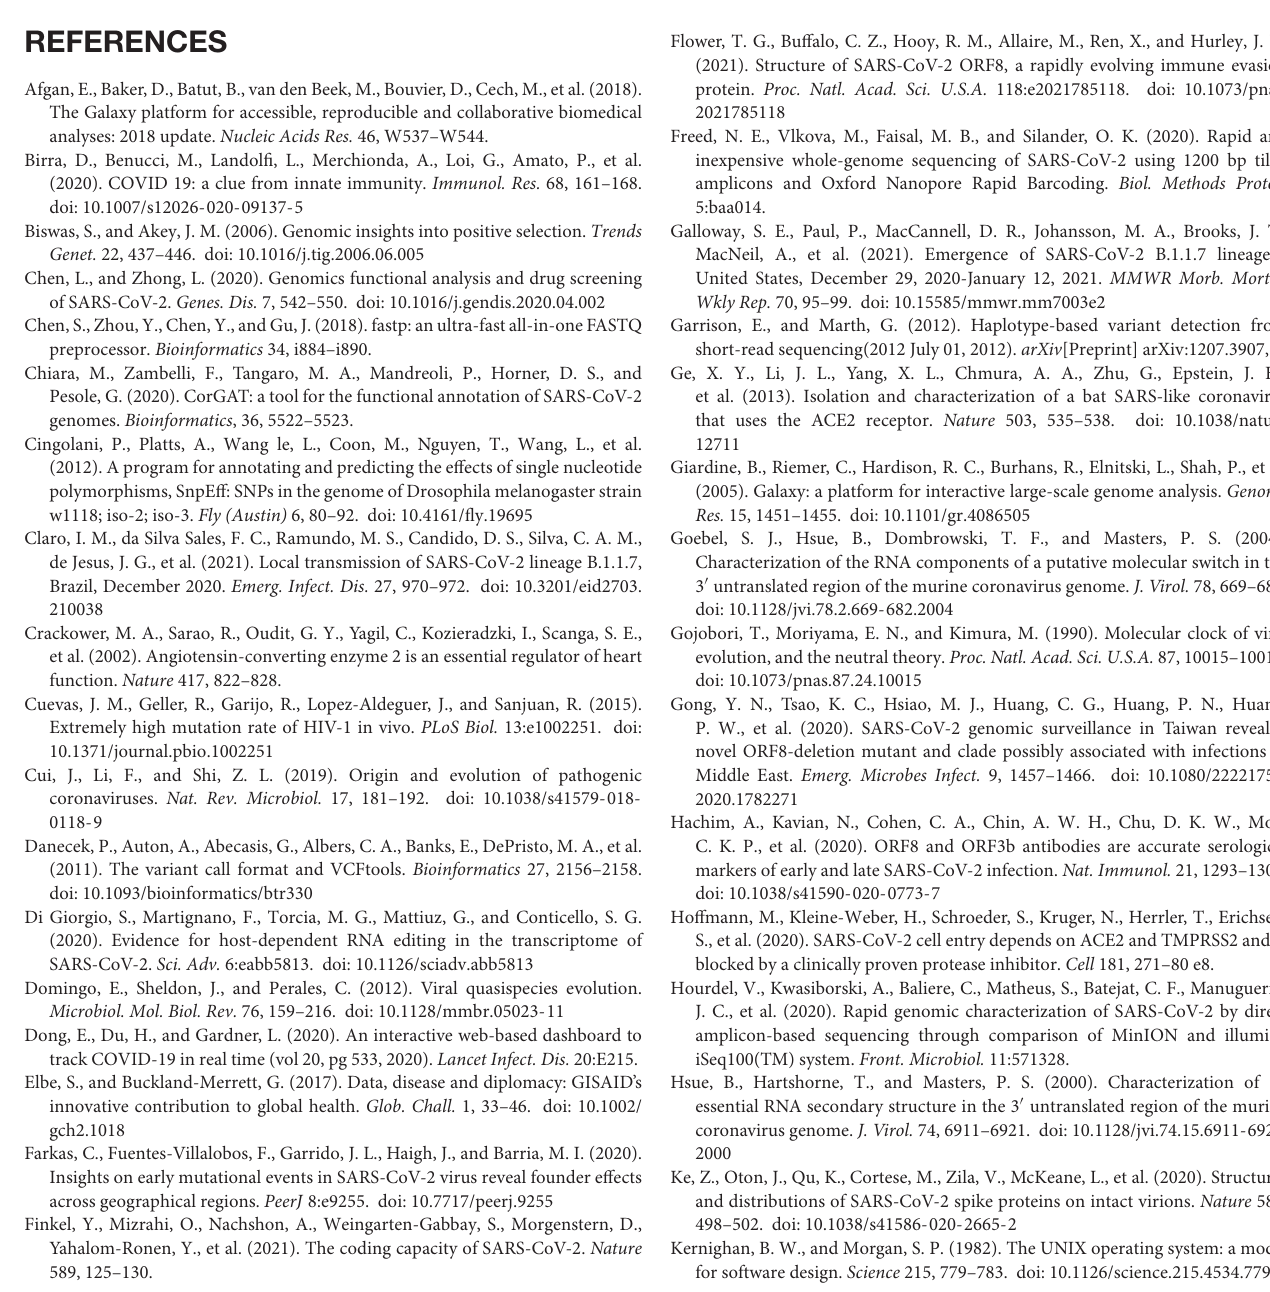
Supplementary Table 3 | Acknowledgments from sequencing laboratories and/or consortia associated with GISAID genomes, listed in Supplementary Table 2